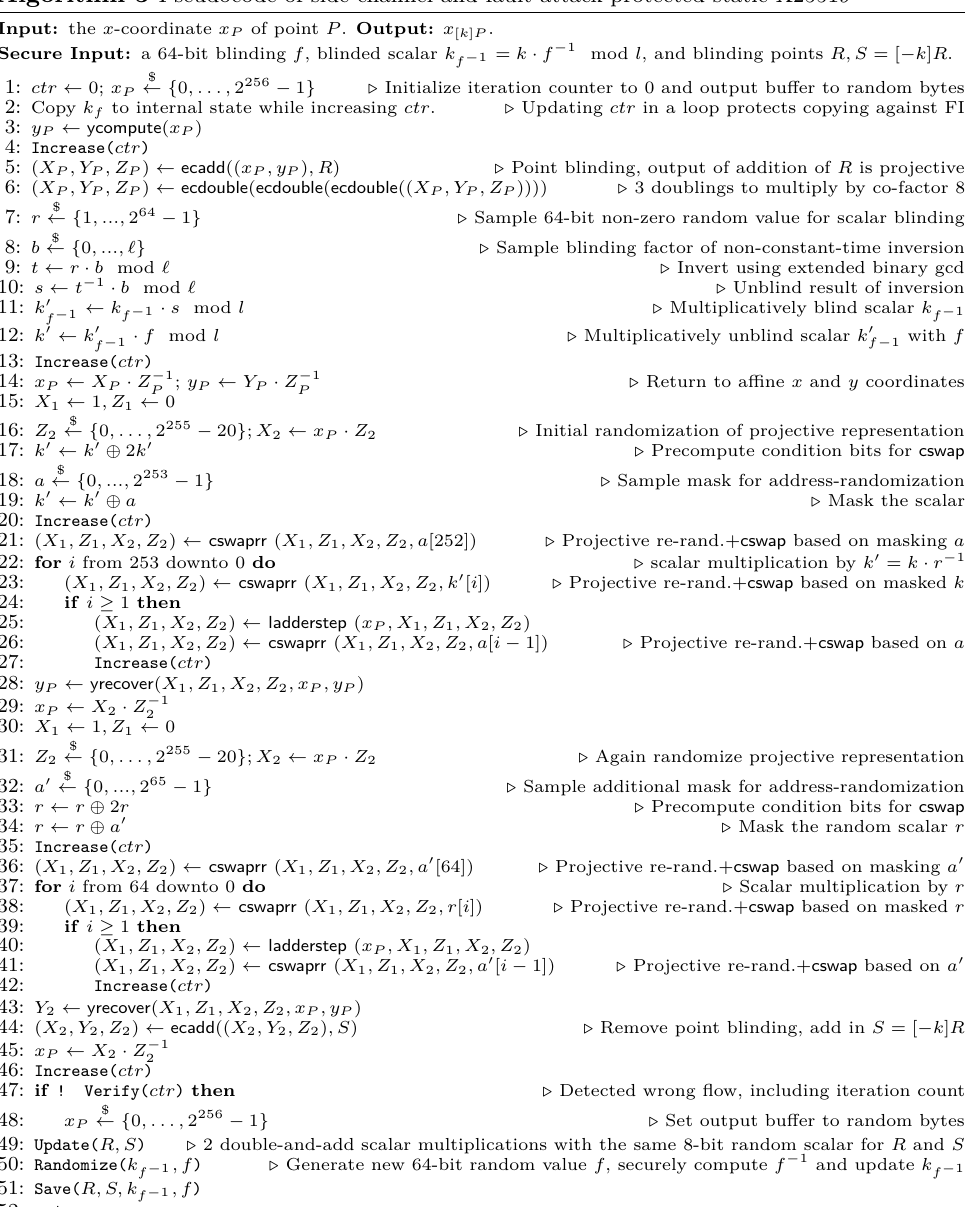
Algorithm 3 Pseudocode of side-channel and fault-attack protected static